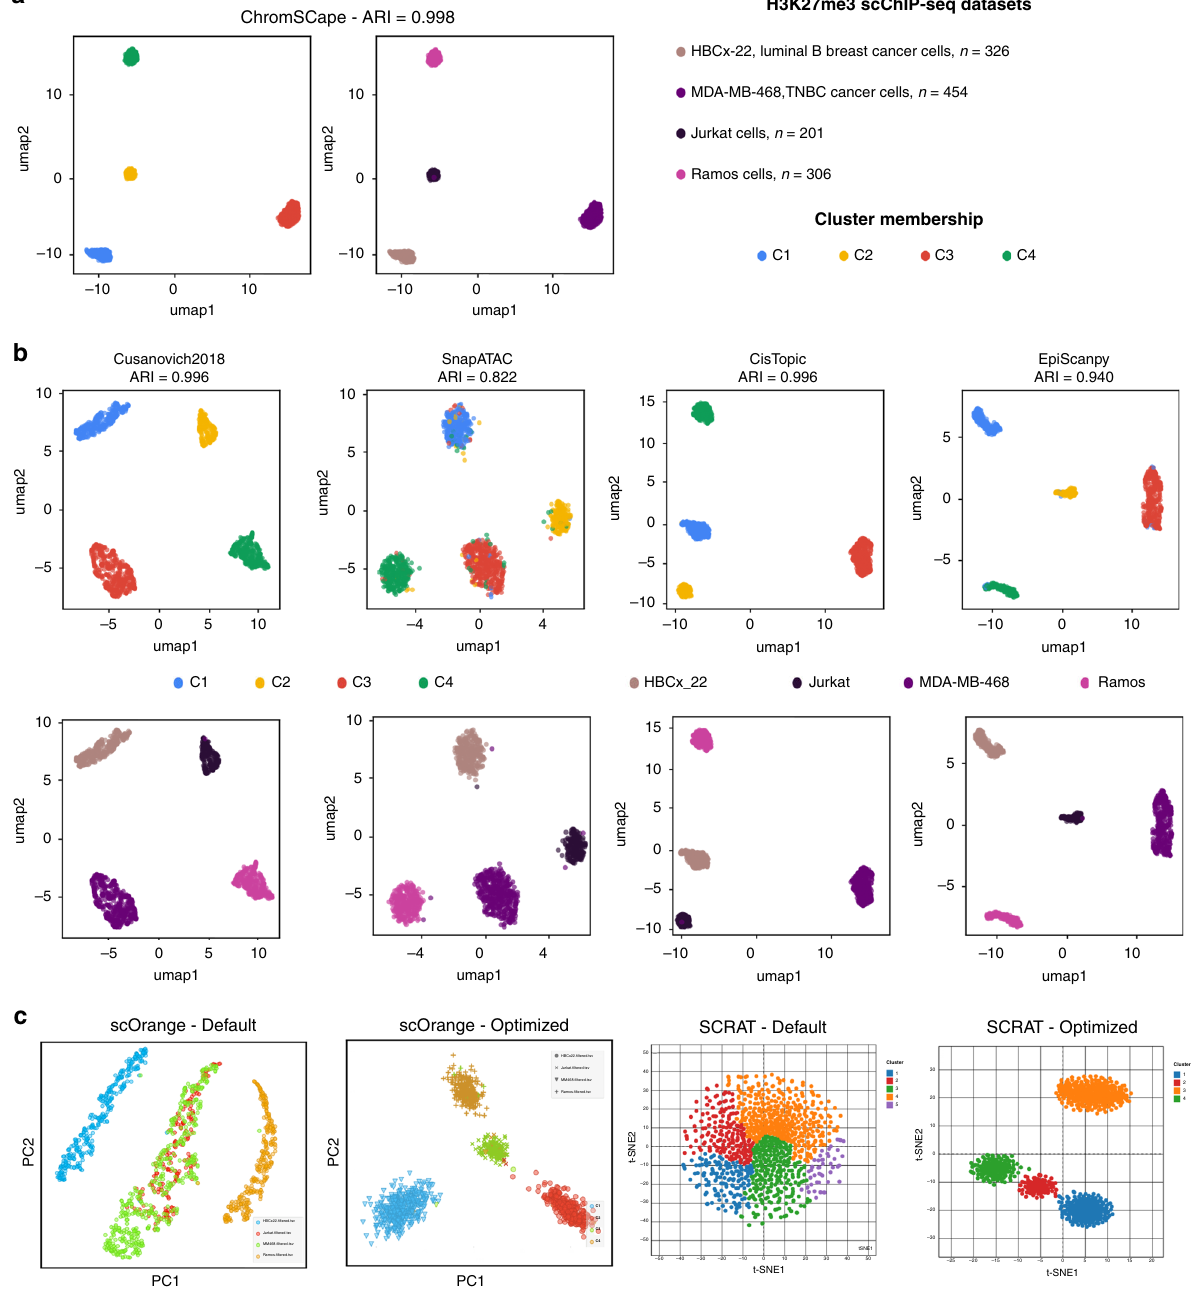
Fig. 2 Benchmarking single-cell epigenomic tools with an in-silico mix of H3K27me3 scChIP-seq. The mix is composed of human cells from an untreated PDX (HBCx-22), human T cells (Jurkat), and B cells (Ramos) taken from 1 and from a TNBC cell line (MDA-MB-468). ( a ) UMAP plots obtained with ChromSCape colored according to cluster and sample of origin. Adjusted Random Indexes (ARI) are indicated above the plot. ( b ) UMAP plots colored according to cluster and sample of origin with other single-cell epigenomic analysis methods: Cusanovich2018 , SnapATAC, CisTopic, and EpiScanpy. Adjusted Random Indexes (ARI) are indicated above the plots. ( c ) Snapshots from scOrange and SCRAT applications. PCA and t-SNE representations from scOrange and SCRAT respectively, using default parameters or after manually optimizing according to sample of origin only with an optimized work fl ow pre-compute counts on pre-de fi ned peaks called on the ‘ pseudo- (Fig. 2c, default vs optimized). SCRAT is a Shiny/R package bulk ’ (see Methods and ‘ Optimized ’ panel), limiting the usability presented as a user interface to analyze single-cell epigenomic data. The default option for SCRAT is to count reads within ‘ ENCODE Clusters ’ corresponding to co-regulatory open chro- matin regions obtained from DNAse-seq datasets, not adapted for the analysis of repressive histone marks like H3K27me3. In order to use SCRAT for our reference scChIP-seq datasets, we had to